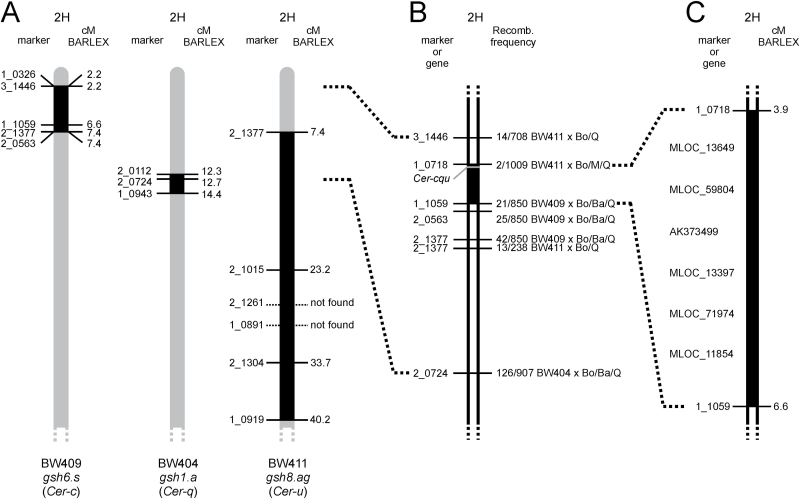
Location of Cer-c, Cer-q and Cer-u on barley chromosome arm 2HS. (A) Comparison of introgression regions in three different barley near-isogenic lines (Druka et al., 2010). BW409 carries the gsh6.s allele, which is a mutation in the Cer-c gene (Franckowiak and Lundqvist, 2012). BW404 and BW411 contain gsh1.a (Cer-q) and gsh8.ag (Cer-u), respectively. Map positions follow the BARLEX Draft Genome Explorer (Colmsee et al., 2015). (B) Mapping of the Cer-c, Cer-q and Cer-u loci using six SNP markers. Recombination frequency for each marker is given as number of recombinants/total progeny. The F2-mapping populations were made from crosses between the three near-isogenic lines and barley cultivars Bowman (Bo), Barke (Ba), Morex (M) and Quench (Q). (C) Cer-c, Cer-q and Cer-u were mapped between SNP markers 1_0718 and 1_1059. Six genes of unknown order were selected as Cer-c, Cer-q and Cer-u candidates for further analysis.